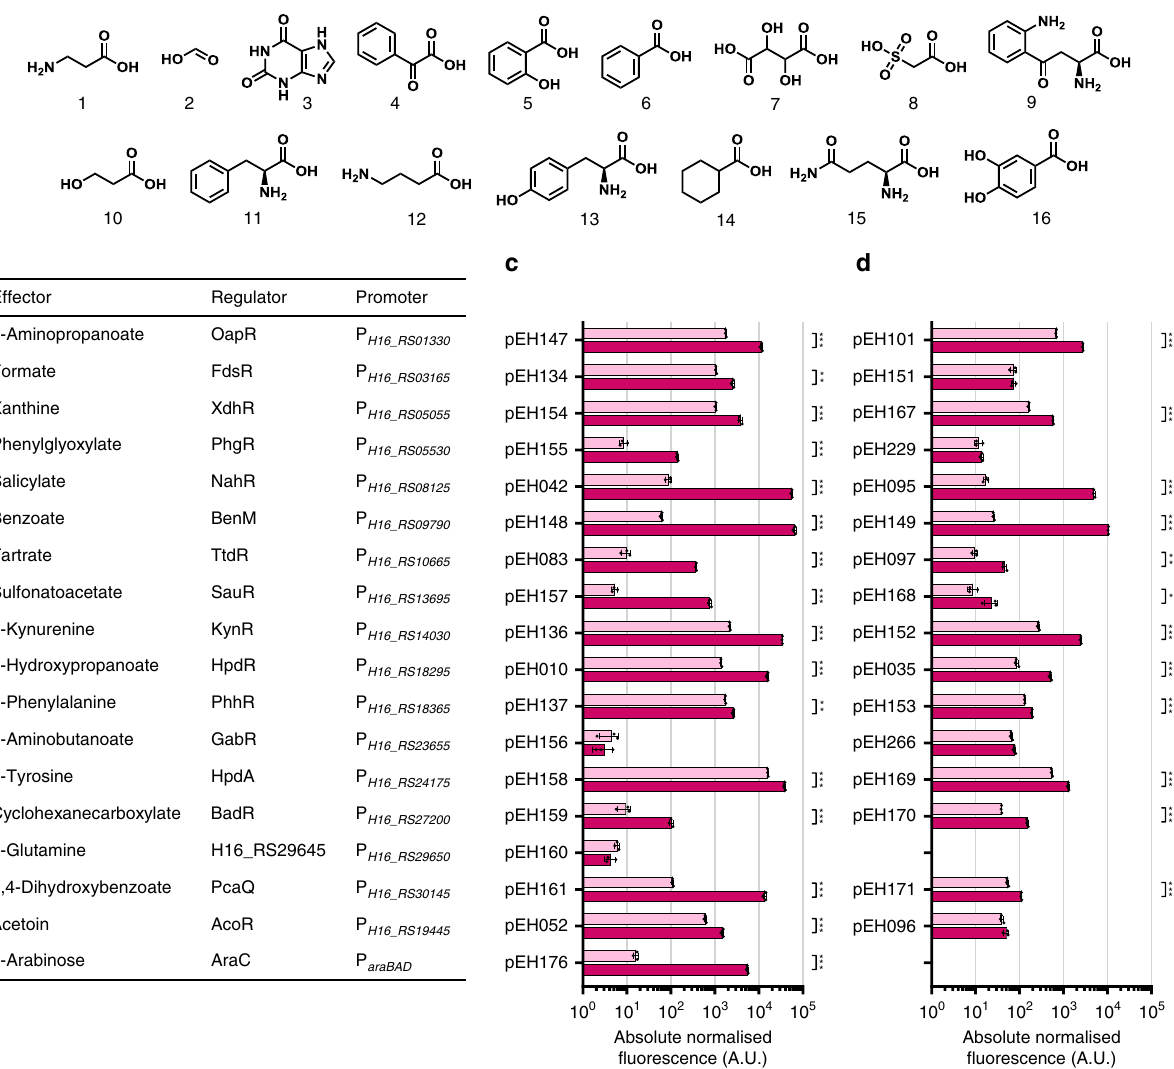
Fig. 2 Quantitative evaluation of native inducible systems. a Chemical structures of the proposed primary effector molecules: β -alanine (1), formic acid (2), xanthine (3), phenylglyoxylic acid (4), salicylic acid (5), benzoic acid (6), tartaric acid (7), sulfoacetic acid (8), L-kynurenine (9), 3-hydroxypropionic acid (10), L-phenylalanine (11), γ -aminobutyric acid (12), L-tyrosine (13), cyclohexanecarboxylic acid (14), L-glutamine (15) and 3,4-dihydroxybenzoic acid (16). b Summary of the identi fi ed inducible systems, including the inducible promoter, TR name and corresponding ligand. c Single time-point RFP fl uorescence measurements (arbitrary units) of C. necator H16 carrying the transcription factor-based inducible gene expression systems composed of TR and inducible promoter in the same order as listed in b . The plasmids harbouring the individual system – reporter constructs are indicated. d Single time- point RFP fl uorescence measurements of C. necator H16 carrying the inducible ‘ promoter only ’ implementations in the same order as listed in b . The plasmids harbouring the individual promoter – reporter gene constructs are indicated. Fluorescence output was determined in the absence of inducer (light magenta) and 6 h after extracellular supplementation with the corresponding effector to a fi nal concentration of 5 mM (dark magenta). Data are mean ± SD, n = 3, * p < 0.05, ** p < 0.001, *** p ≤ 0.0001, unpaired two-tailed t -test. Source data are provided as a Source Data fi